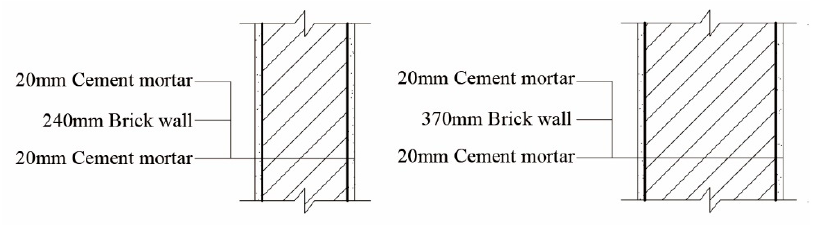
Figure 1. Exterior walls. Energies 2020 , 13 , x FOR PEER REVIEW